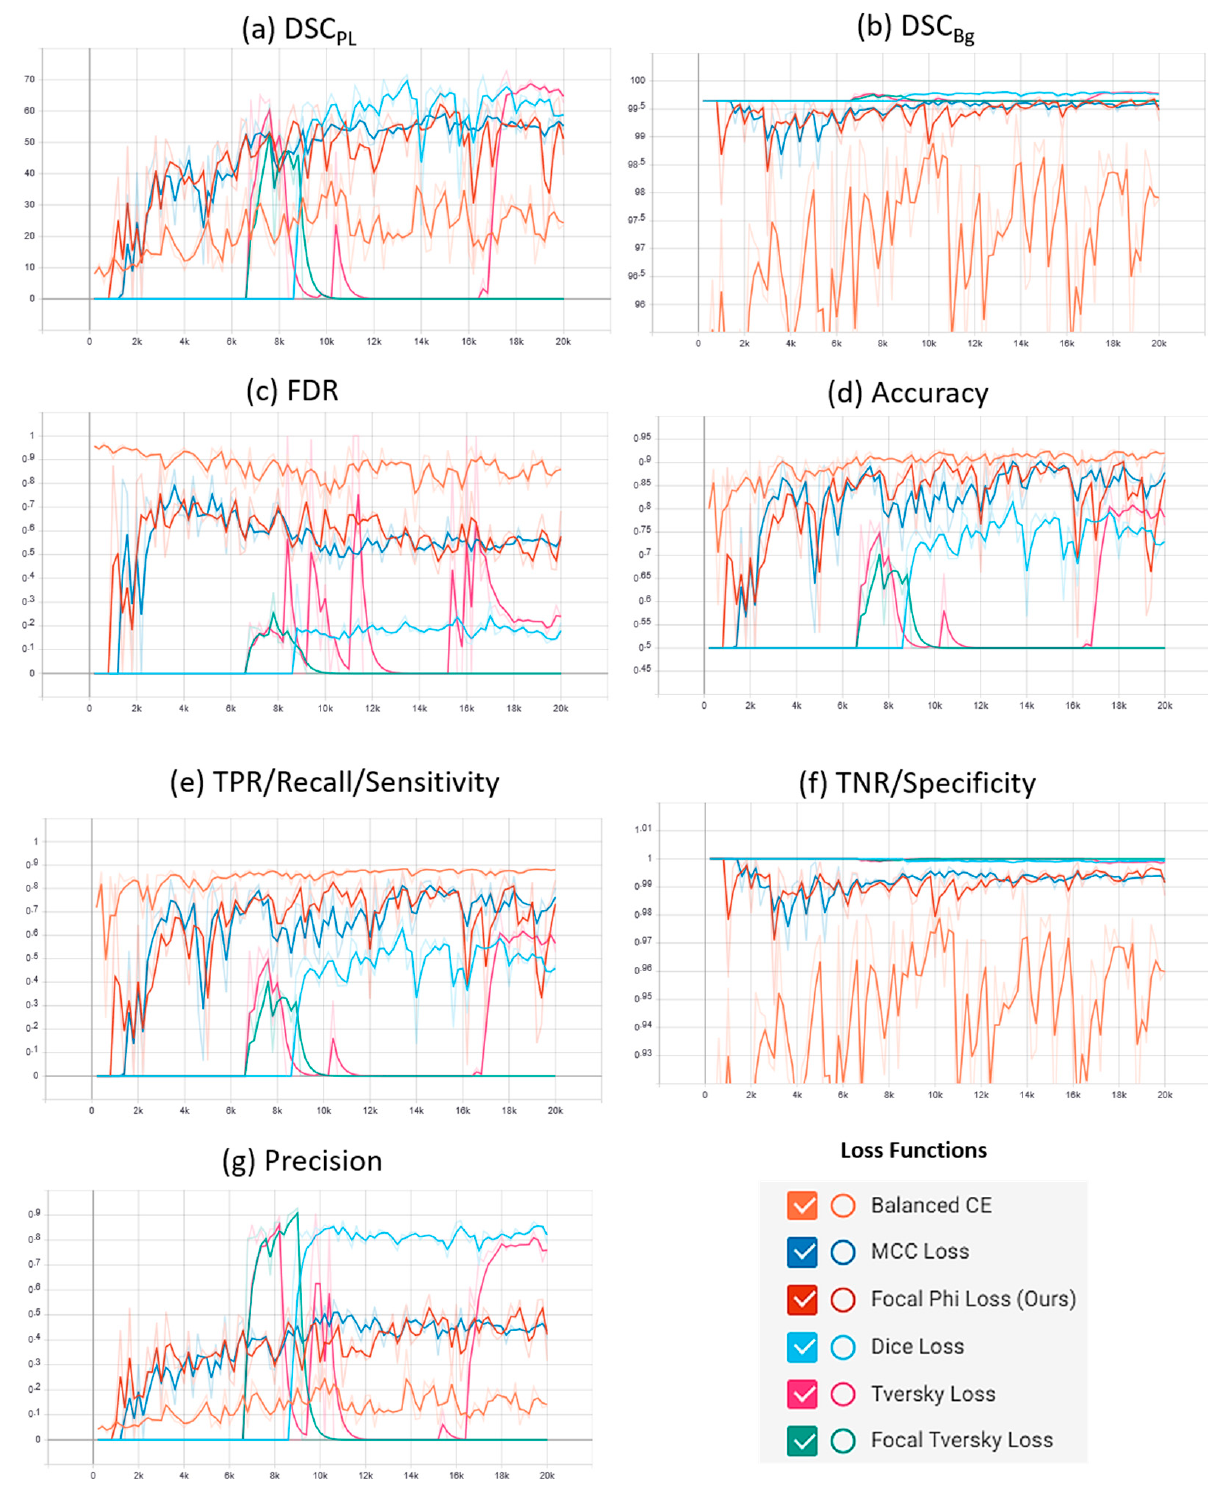
Figure 6. Comparative analysis of the proposed focal Phi loss (FPL) function with various loss functions for class imbalance on the Mendeley PL dataset.